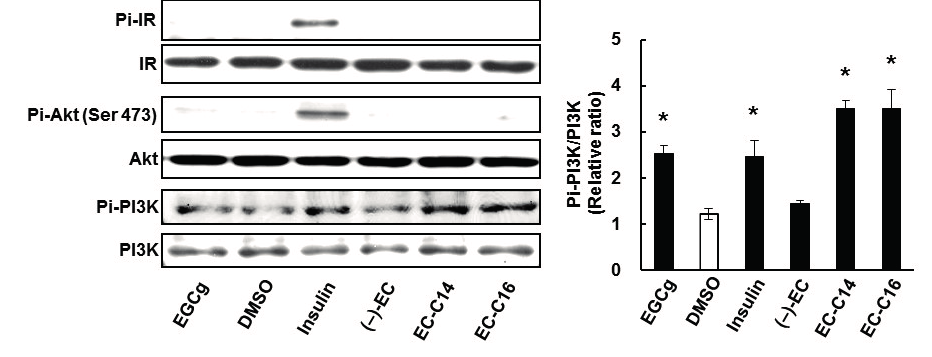
Figure 7. The effects of 3- O -acyl-( − )-epicatechins on GLUT4 translocation on insulin signaling pathway in L6 myotubes. Differentiated L6 cells were incubated with 3- O -acyl- ( − )-epicatechins at 100 nM for 15 min. The phosphorylation and expression of IR, Akt, and PI3K were detected by Western blot analysis. Band density was determined by ImageJ analysis software. Data are shown as the mean ± SE ( n = 3). * p < 0.05 vs. DMSO-treated control cells by a Dunnett multiple comparison